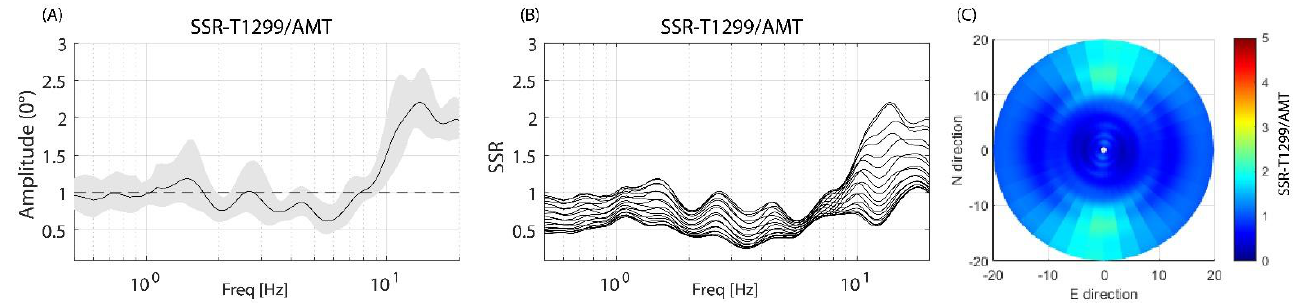
Figure 3. Standard spectral ratio (SSR) of T1299 with respect to AMT. ( A ) average SSR and the associated standard deviation along the N–S direction; ( B ) average SSR calculated along 18 horizontal directions every 10 ◦ ; ( C ) polar plot showing the amplification along different azimuthal directions from 0 Hz (center of polar plot) to 20 Hz.